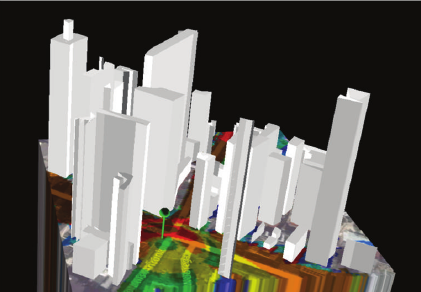
Figure 3: A tridimensional view of the BS among densely tall buildings. Antenna height is 30m, azimuth is 0 ∘ , tilt is 10 ∘ , and half-power angle is 88 ∘ and 26 ∘ , for horizontal and vertical planes, respectively, EIRP = 1000W and 𝑓 = 900